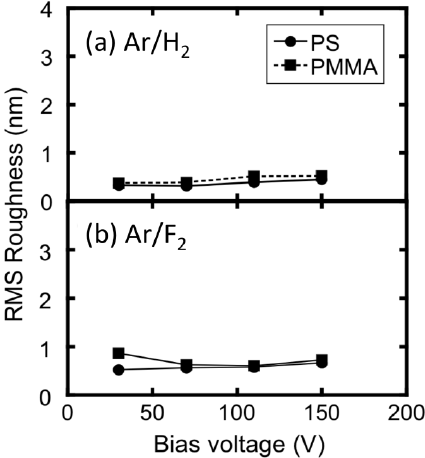
Figure 7. RMS roughness of ( a ) Ar/H (circles) and PMMA films (squares) etched with different substrate bias